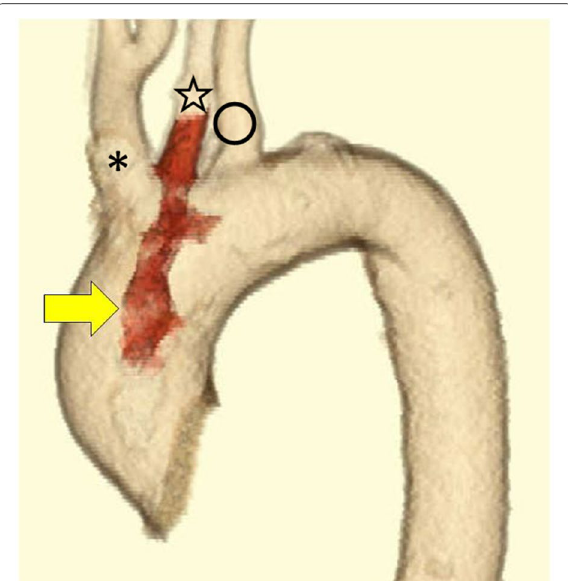
Fig. 2 A multiplaner reconstruction CT image showing the cylinder thrombus in the aortic arch and left common carotid artery